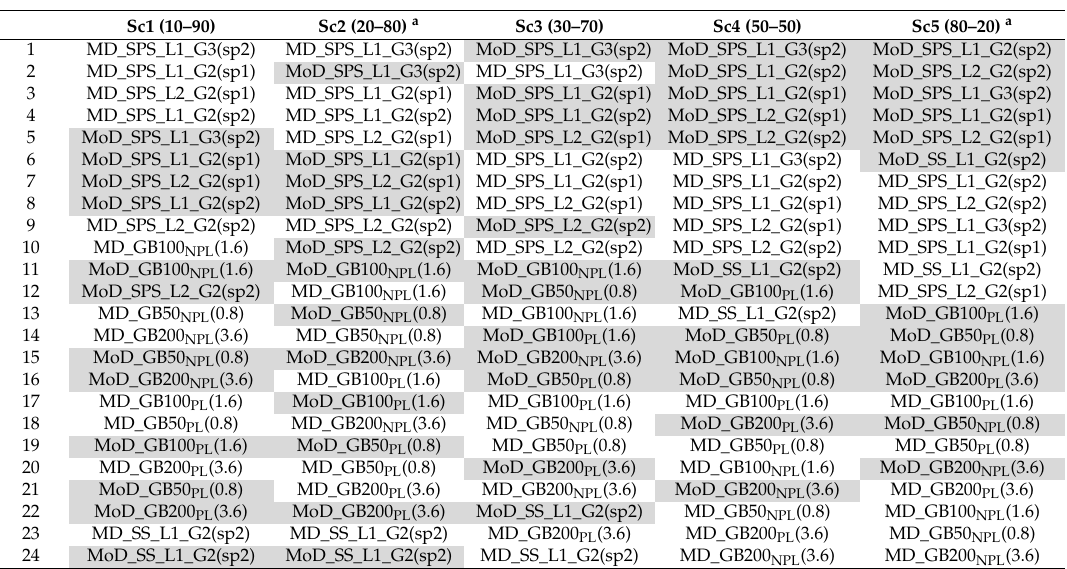
Table 8. Ranking of best alternatives depending on the priorities assigned to economic returns or water saving change from Sc1 (higher for economic returns) through Sc5 (higher for water savings) when mild and moderate-deficit irrigation (shaded) are adopted for sprinkler and graded border